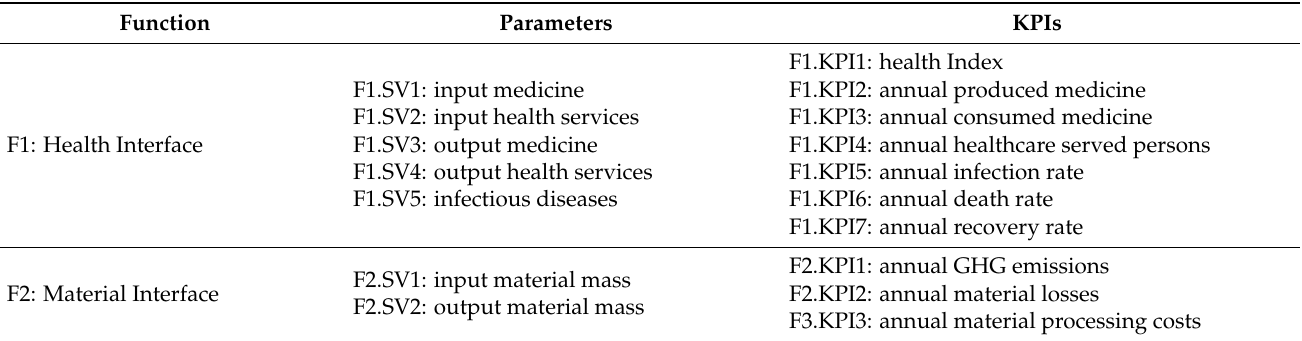
Figure 12. Key performance indicators and different monitoring criteria. Table 2. Unified interface system design: functions and parameters.